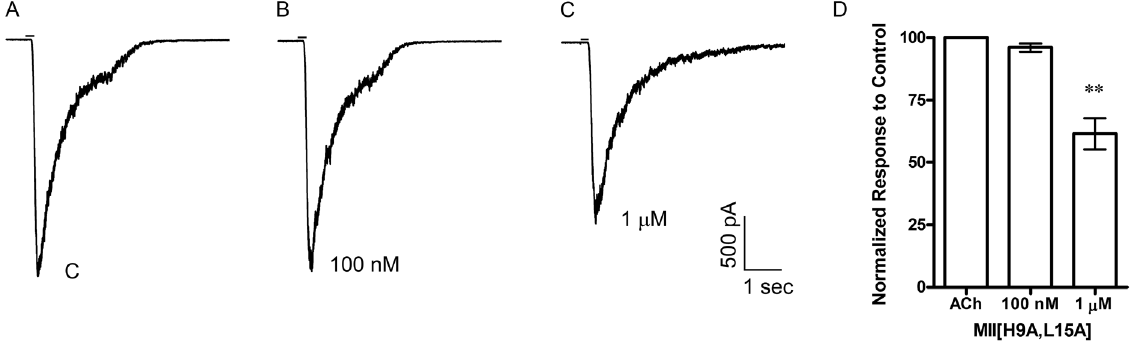
Figure 6. a -Ctx MII[H9A,L15A] inhibits ACh-evoked responses less potently in mouse adrenal chromaffin cells. A, Representative trace recordings of ACh-evoked currents and the inhibition by 100 nM and 1 m M MII[H9A,L15A]. B, Quantitative analysis of the inhibition by 100 nM (n=6) and 1 m M MII[H9A,L15A] (n=6). Statistical analysis of the inhibition by 100 nM indicated no statistical significance compared to control responses ( p . 0.05) but significance for 1 m M ( p , **0.01); error bars show average values 6 S.E.M.